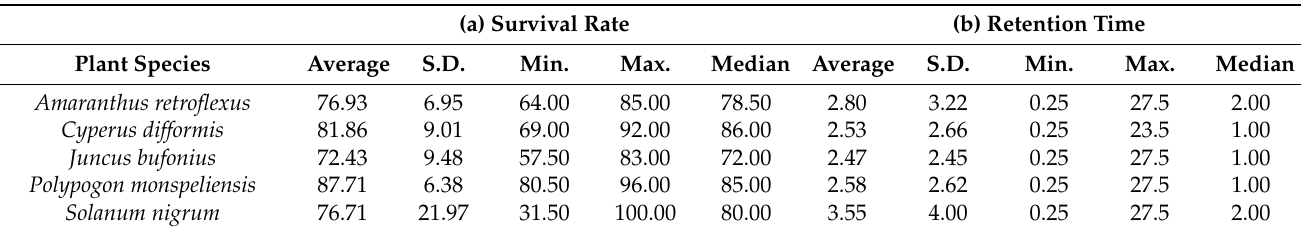
Table 1. (a) Percentage of seeds of each plant species that survived gut passage through seven lesser black-backed gulls. (b) Average retention time (in hours) for seven gulls. S.D.: Standard deviation, Min: minimum, Max: maximum.